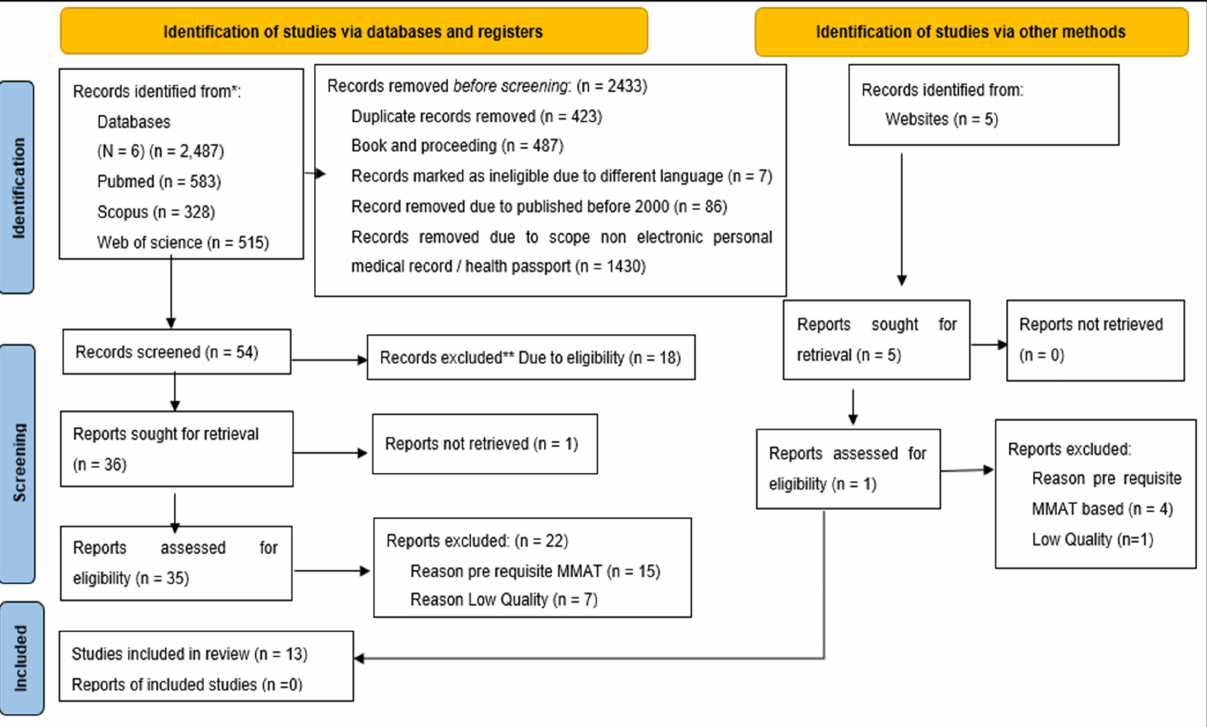
Figure 1. PRISMA 2020 flow diagram for new systematic reviews, which included searches of databases, registers, and other sources. * Consider, if feasible to do so, reporting the number of records identified from each database or register searched (rather than the total number across all databases/registers). **If automation tools were used, indicate how many records were excluded by a human and how many were excluded by automation tools .